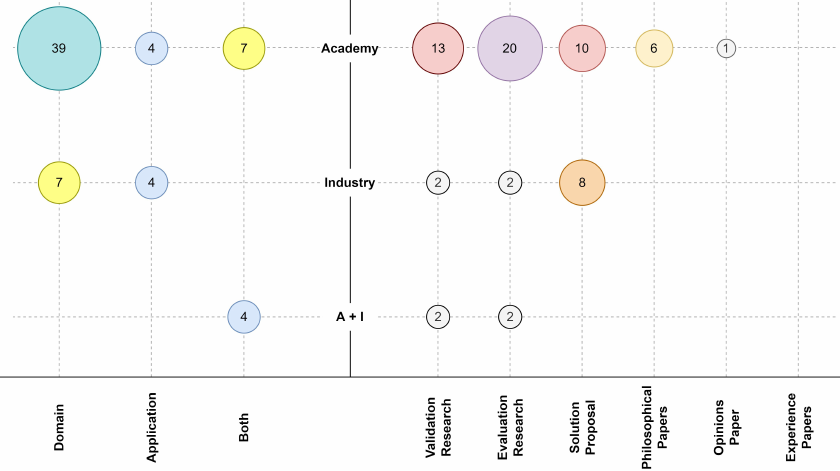
Figure 27. Summary of SLP stages, origins, and validations of